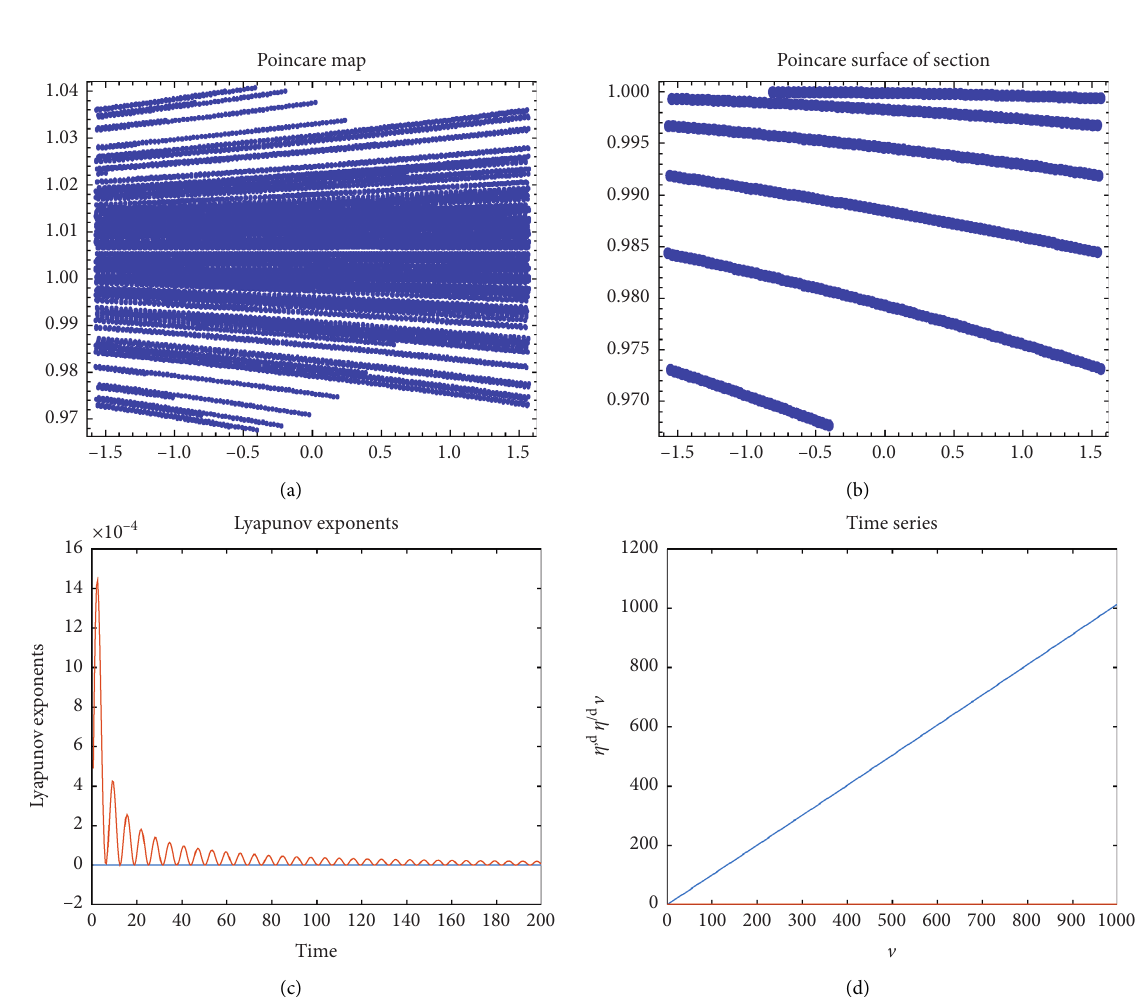
� 3 . 36 E + 09 ,D � − 4 E + 08 , B � 1596 . 387 , C � − 103631 ,E � 200 . 1022 , ∗ ∗ ∗ ∗ ∗